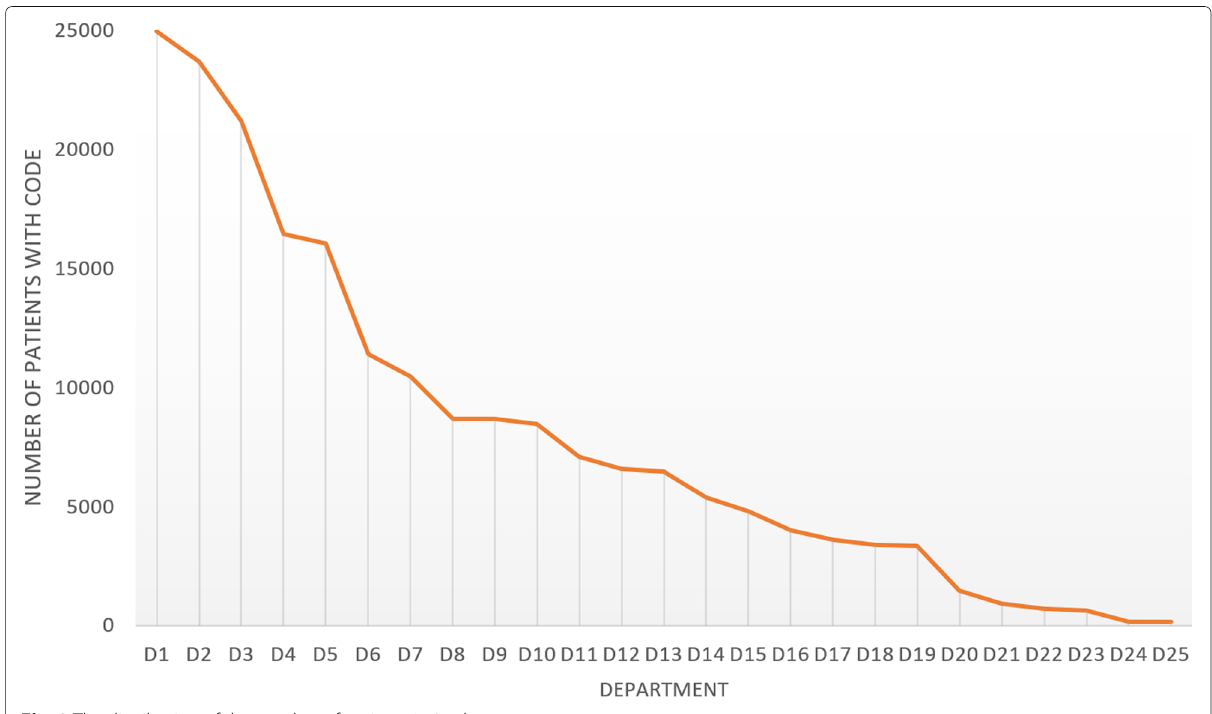
Fig. 3 The distribution of the number of patients in 25 departments